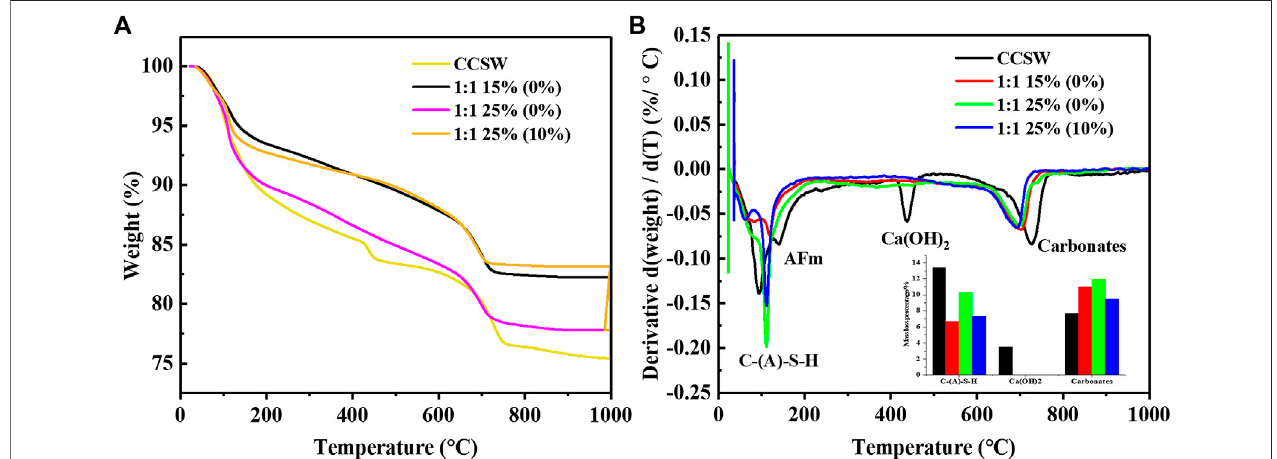
FIGURE 9 | TG-DTG results of CCSW and GCSW composites ( A: TG curves, B : DTG curves).